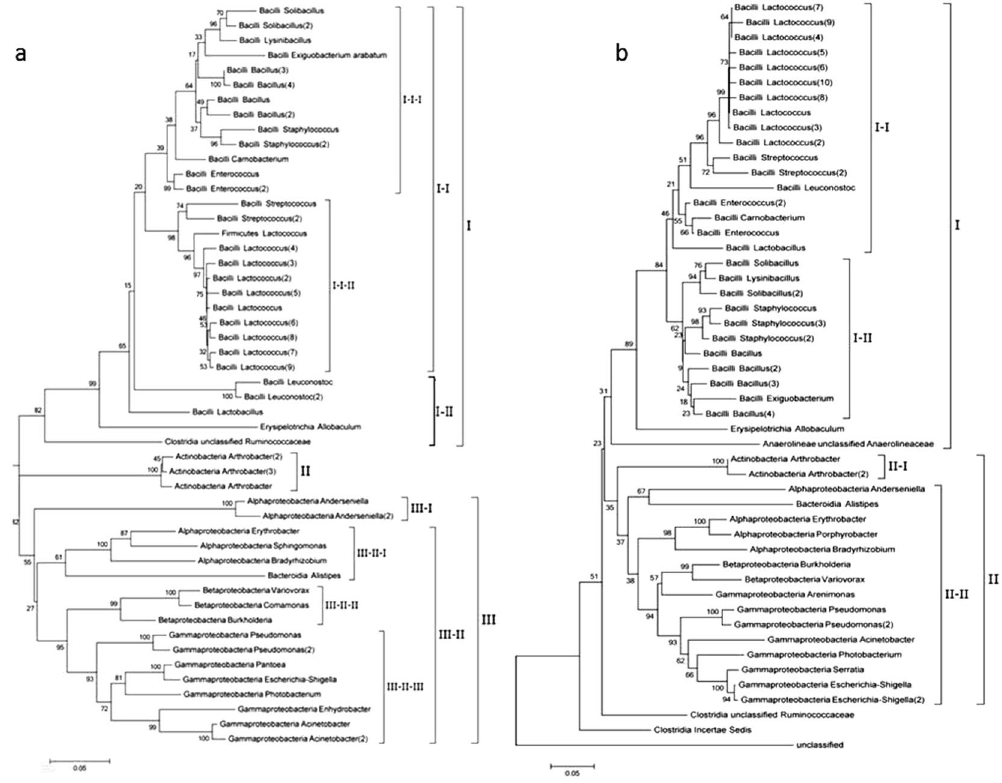
Figure 6. Phylogenetic tree of top 50 dominant OTUs. The phylogenetic tree was constructed using the Maximum Likelihood method. ( a ) Control samples; ( b ) THTT samples.